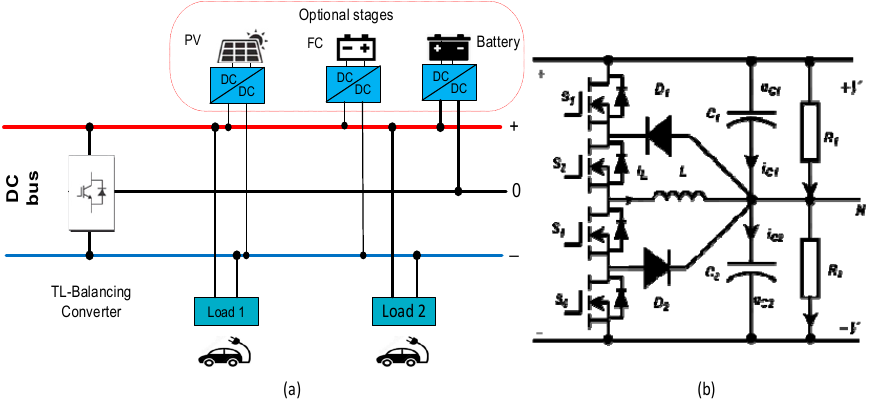
Figure 1. Structure of bipolar DC charging station ( a ) with independent converters and loads, and ( b ) diagram of the three-level balancing DC–DC converter.